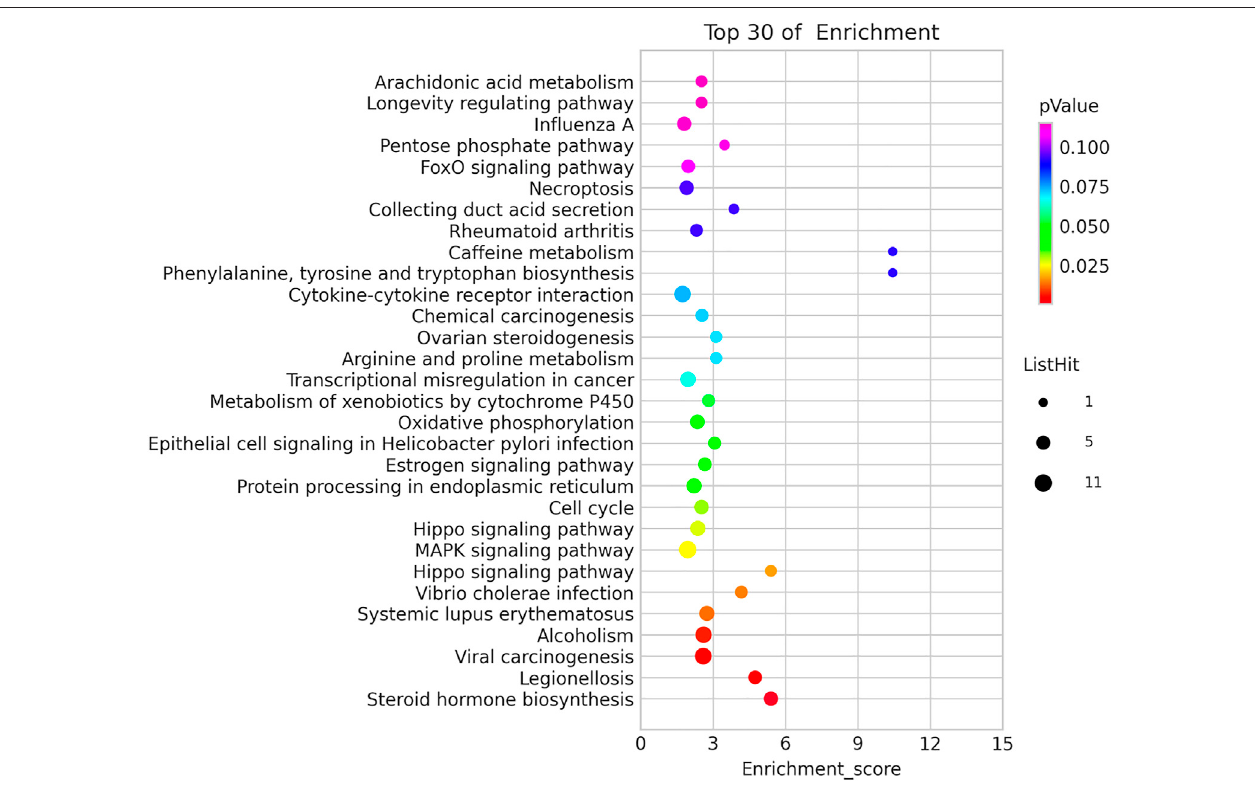
FIGURE 5 | Kyoto Encyclopedia of Genes and Genomes (KEGG) pathway analysis.